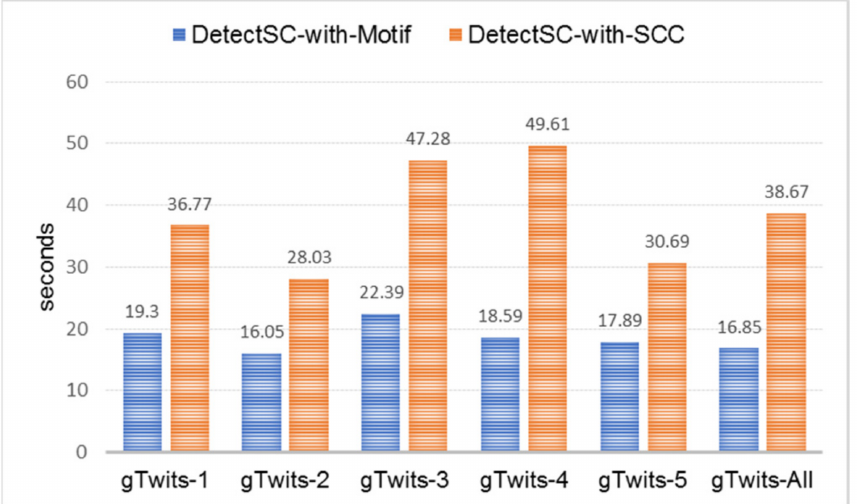
Figure 9. Execution time of detecting